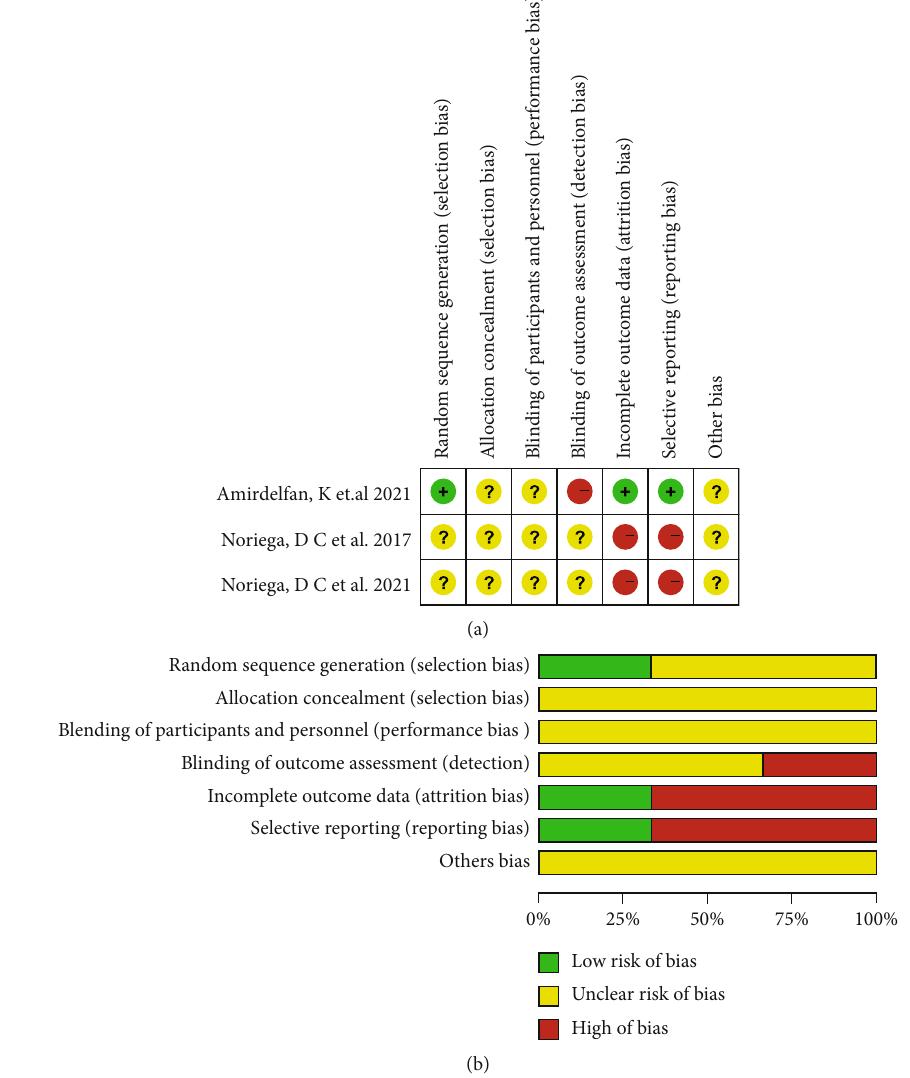
Figure 2: Quality evaluation of studies by the Cochrane collaboration manual. (a) Item-by-item detailed analysis of the summary of the risk of bias in studies. (b) The risk bias graph shows the quality summary of the